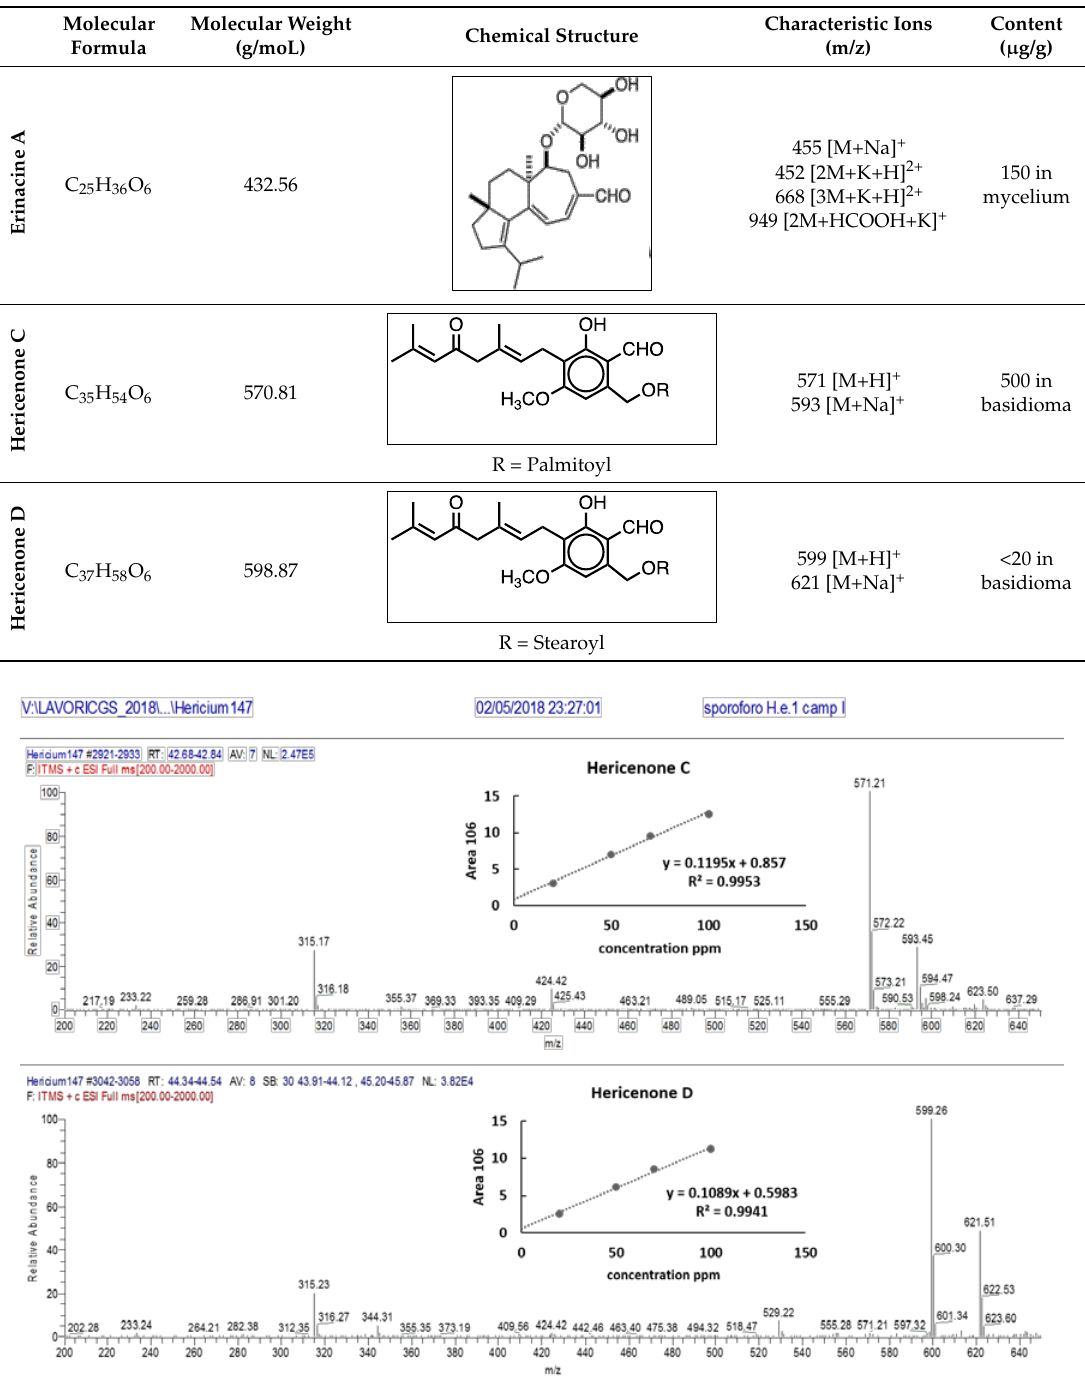
Figure 5. ESI/MS spectra of Hericenone C and D. Panels (top, right) report calibration curves for Hericenone C and D.